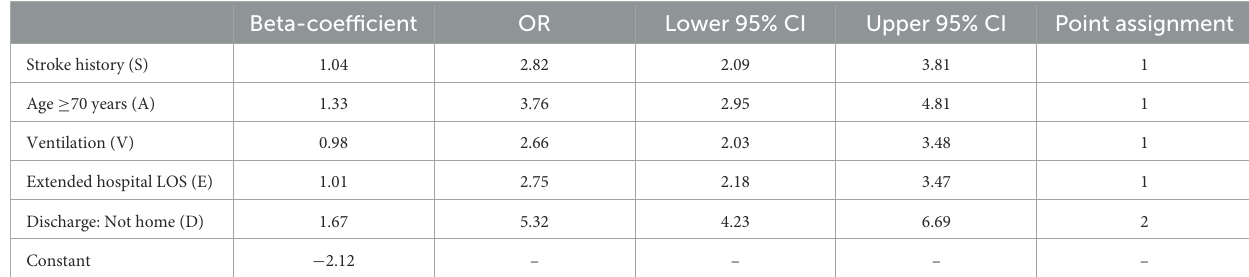
TABLE 4 Derivation of SAVED 2 in ERICH: association of covariates with unfavorable mRS score (3–6) upon multivariable logistic regression and corresponding point assignment in SAVED 2 . Beta-coefficient OR Lower 95% CI Upper 95% CI Point